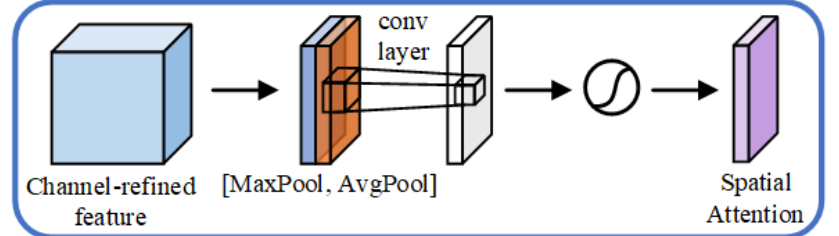
Figure 6. The structure of the spatial attention module, reprinted with permission from Ref. [21]. 2018, Springer Nature.